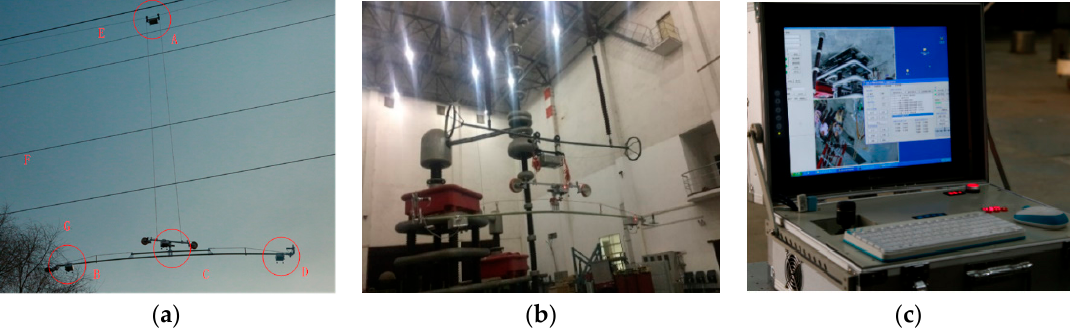
Figure 14. Field experiment and withstand voltage test. ( a ) BTR and mobile nodes in the field